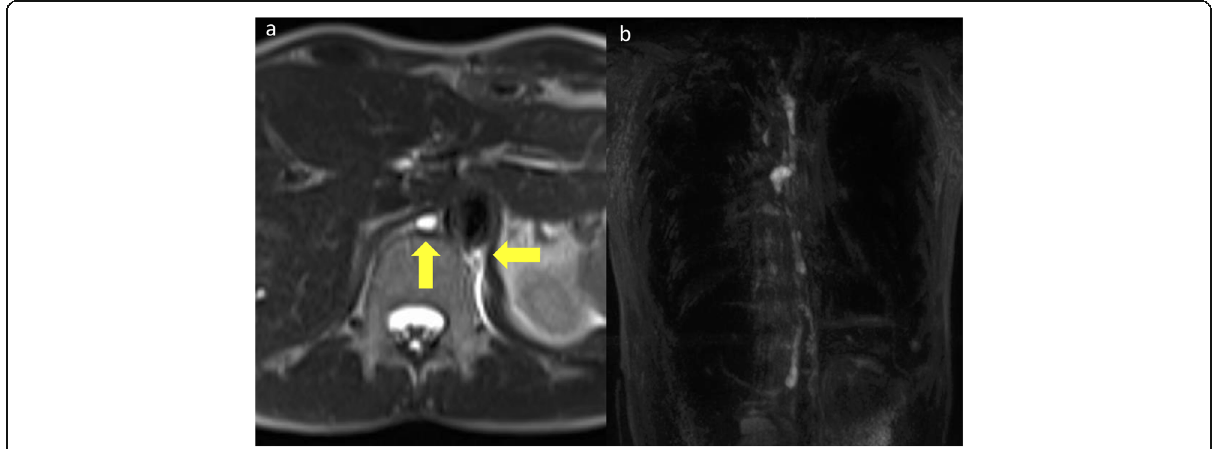
Fig. 2 a MRI 10 days after admission revealed two thoracic ducts running through the thoracic cavity. b Coronal imaging of